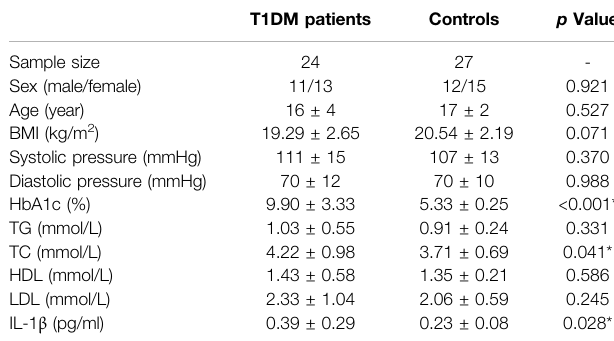
TABLE 1 | Descriptive characteristics and IL-1 β expression of the T1DM patients and